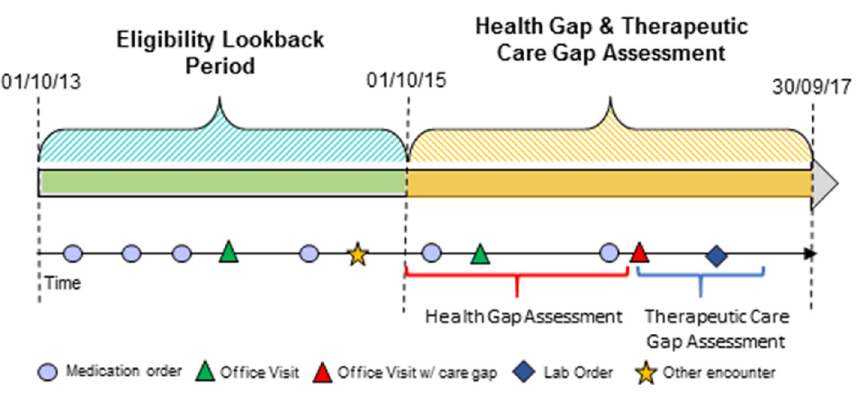
Figure 1. Retrospective use of EHR data to identify eligible primary care patients, as well as health and care gaps.